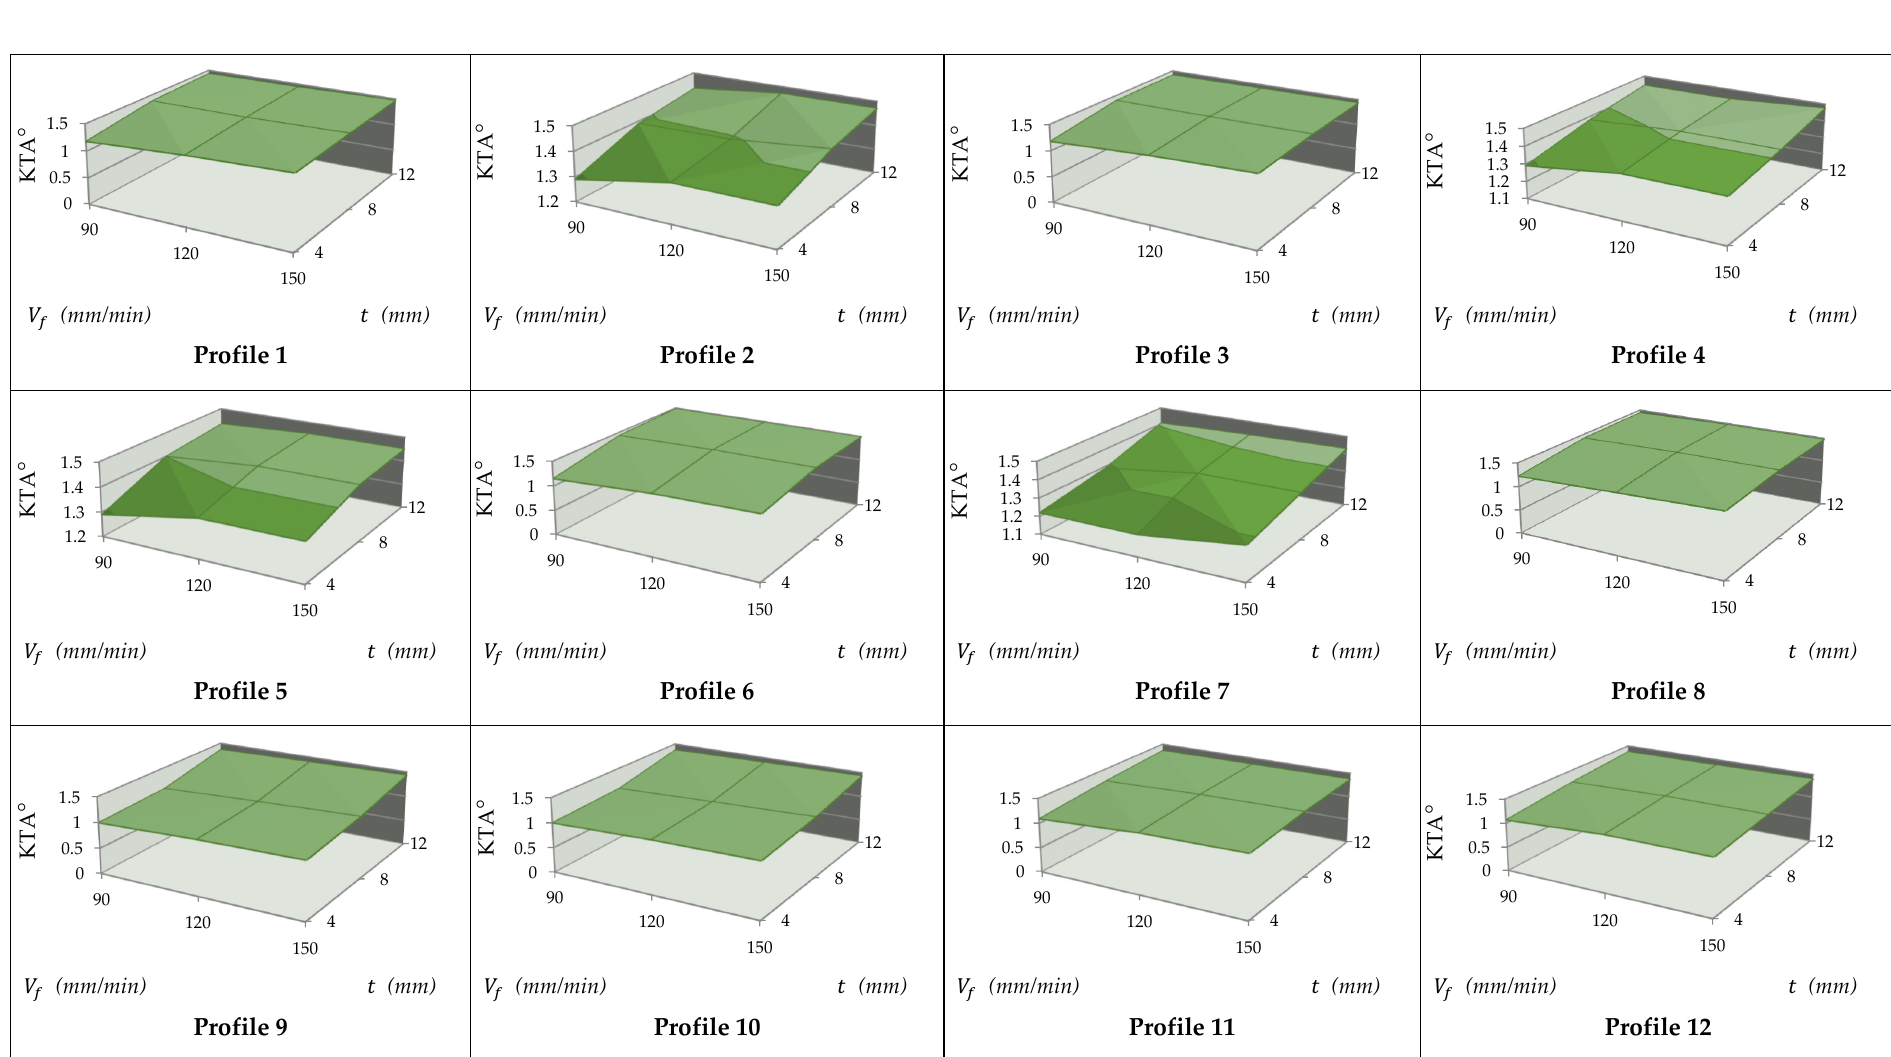
Figure 6. Impacts of material thickness and traverse speed on Kerf taper angle in AWJ profile cutting of AISI304L.